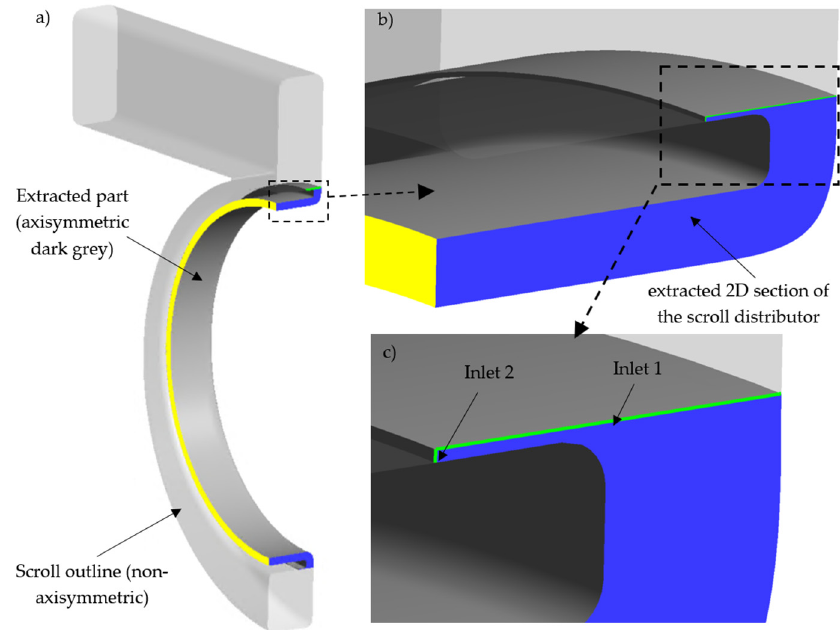
Figure 6. Scroll problem downsizing: ( a ) general view of the scroll—non-axisymmetric part (light gray) and the part extracted for downsizing (dark gray); ( b ) cross-section used in optimization procedure; ( c ) Inlet positions in the extracted part of scroll.